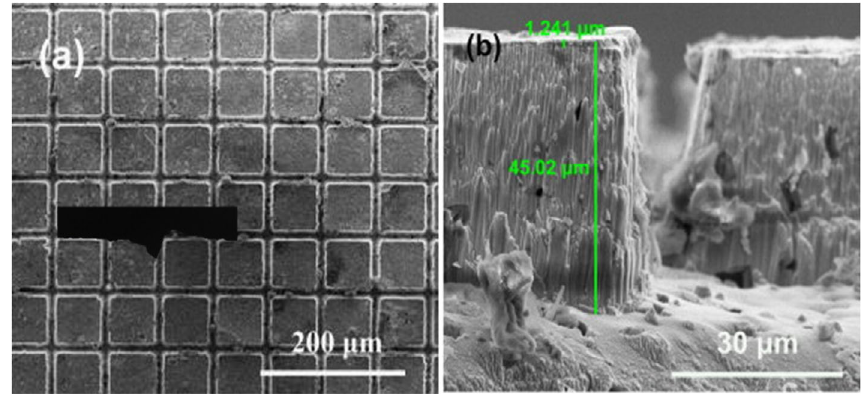
Fig. 26 SEM images of PZT ceramic layer after 7 h etching: (a) top surface, (b) cross section. Reproduced with permission from Ref. [184], © Elsevier Ltd and Techna Group S.r.l.